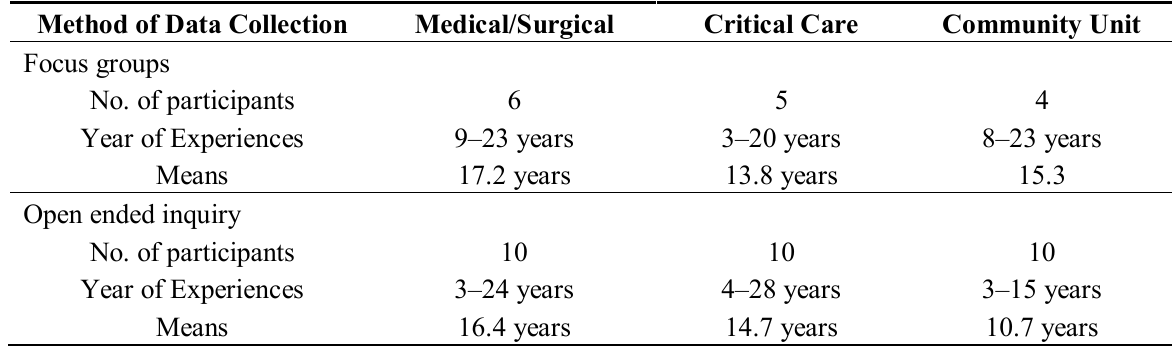
Table 1. Clinical experience of the